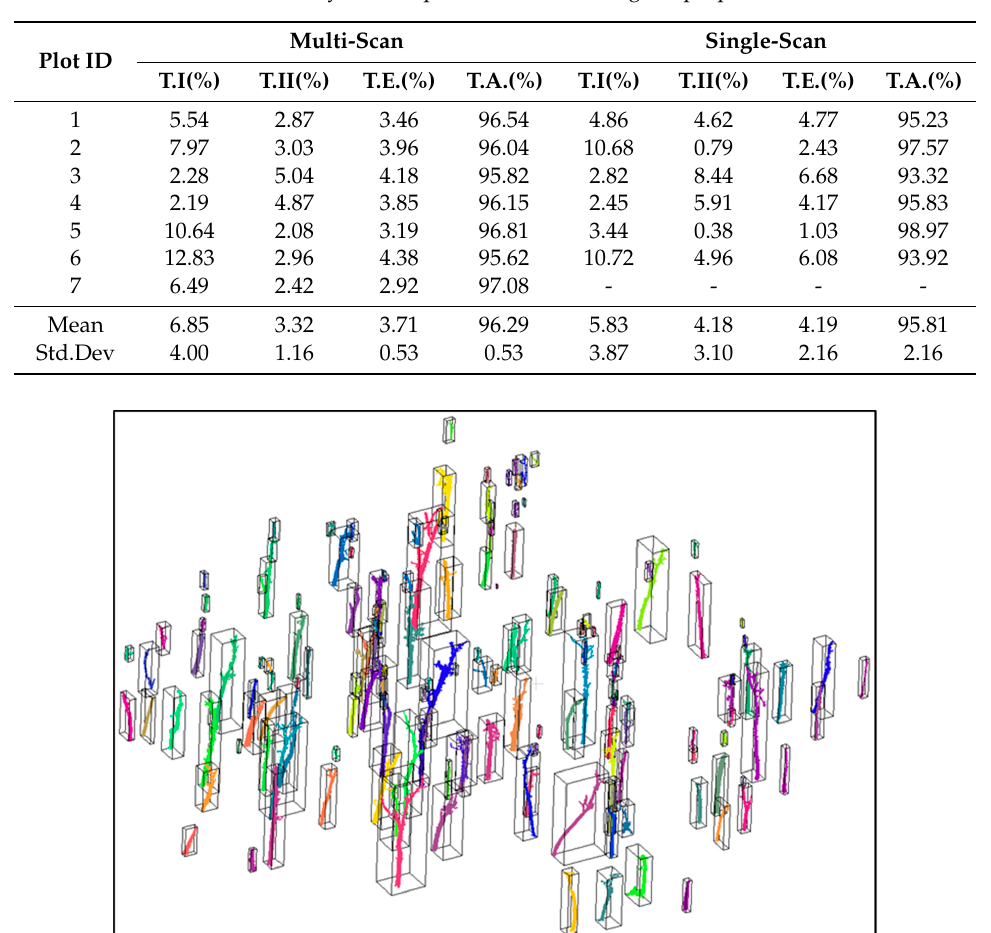
Table 2. The accuracy of stem point extraction using the proposed method.